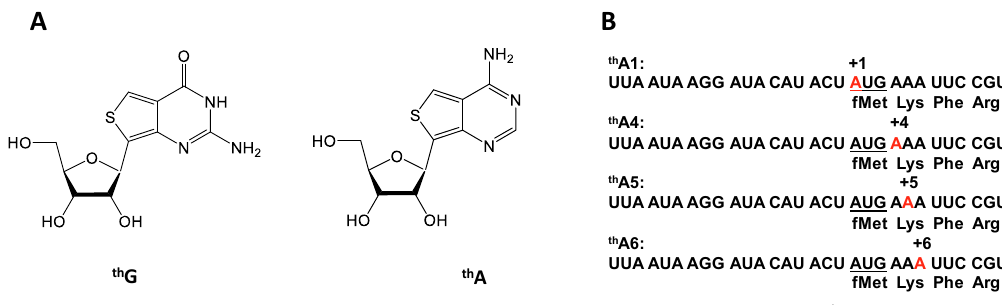
Figure 1. ( A ) Isosteric guanosine and adenosine surrogates th G and th A; ( B ) mRNAs site-specifically labeled with th A (in red).